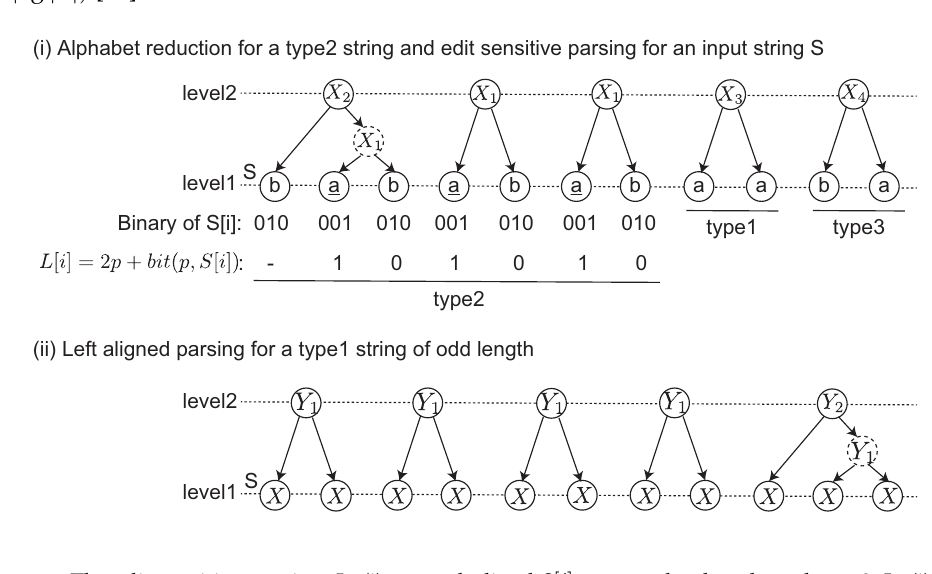
Figure 1. The edit sensitive parsing. In (i), an underlined S [ i ] means a landmark, and p ≥ 0. In (i) and (ii), a dashed node is corresponding to the intermediate node in a